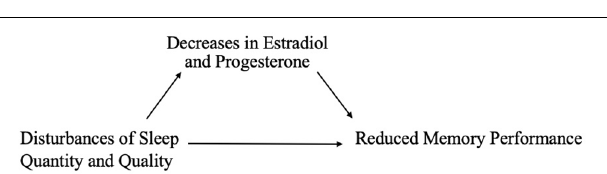
FIGURE 1 | Interrelationships of changes in estradiol and progesterone with sleep, brain function, and memory across the menstrual cycle.